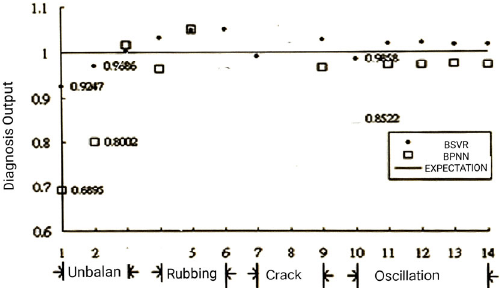
Figure 5. BSVR and BPNN output of detection.